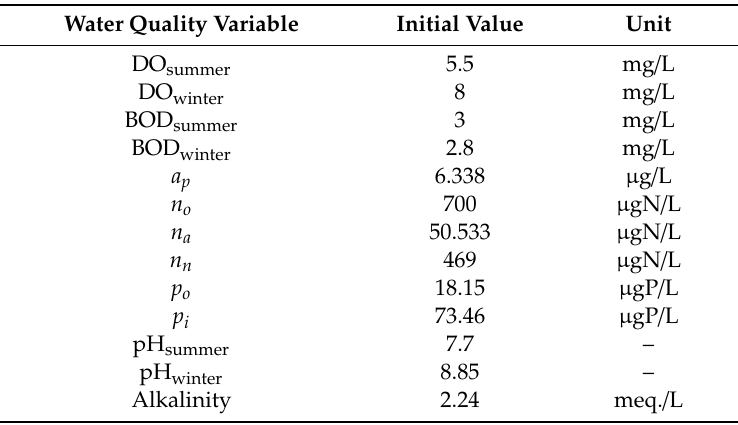
Table 2. Initial concentrations of the studied water quality variables.